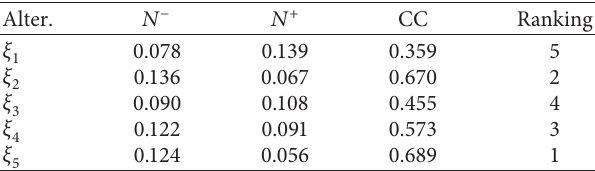
Table 12: Separation measure and the relative closeness coefficient of each alternative.